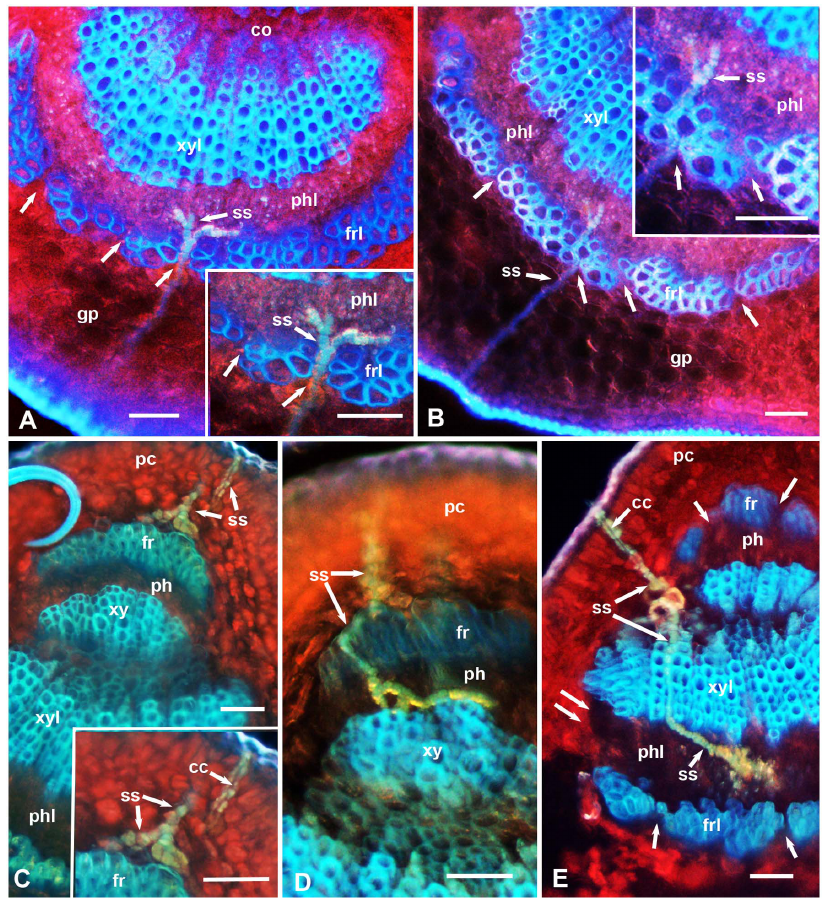
Figure 2. Epifluorescence micrographs showing stylet sheaths (ss) of D.citri in cross sections of the midrib in leaves of the relatively resistant (UN-3881) plants. In A–E, the upper (adaxial) leaf side is up, and the lower (abaxial) side is down; unlabeled single arrows indicate smaller gaps in the fibrous ring; double arrows indicate wider gaps in this ring at the sides of the vascular bundle. Abbreviations: cc, central canal in the stylet sheath; co, core cells; fr, upper fibrous ring; frl, lower fibrous ring; gp, ground/spongy parenchyma; pc, palisade parenchyma cells; ph, upper phloem; phl, lower phloem; ss, stylet sheath; xy, upper xylem; xyl, lower xylem. Scale bars=50 m m.